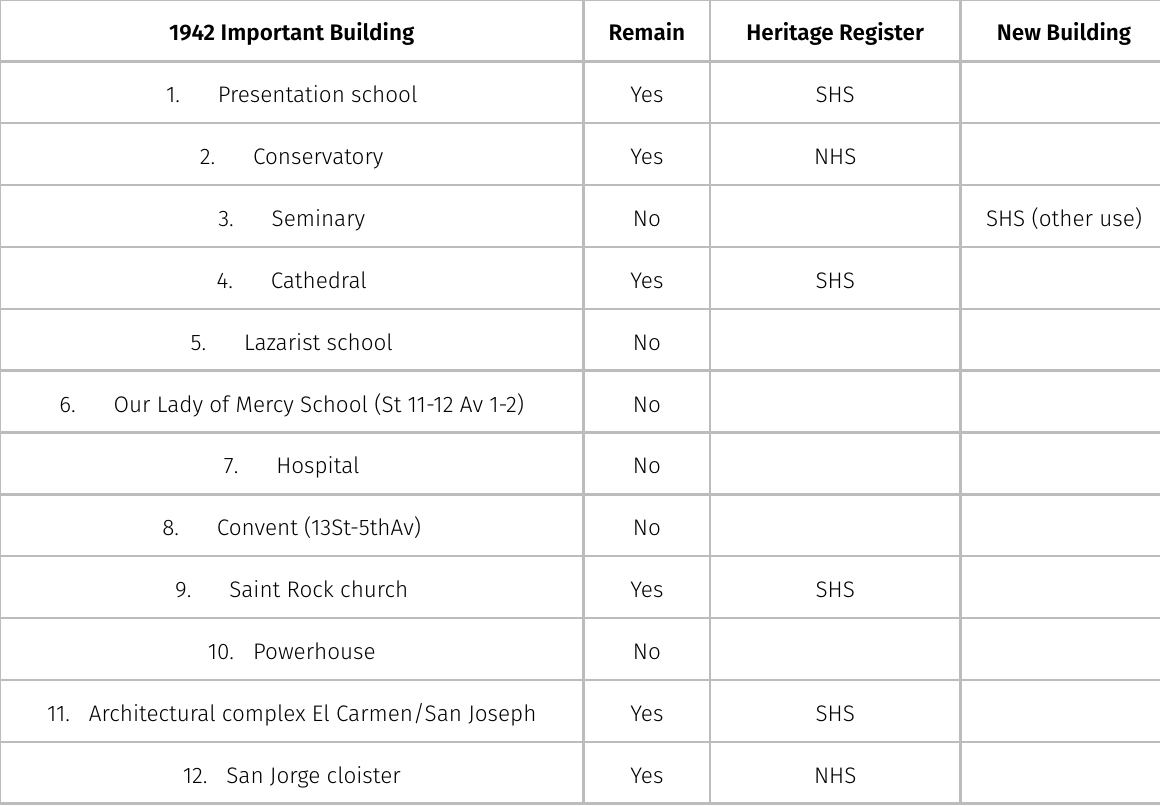
Table II. Important buildings in 1942. 1942 Important